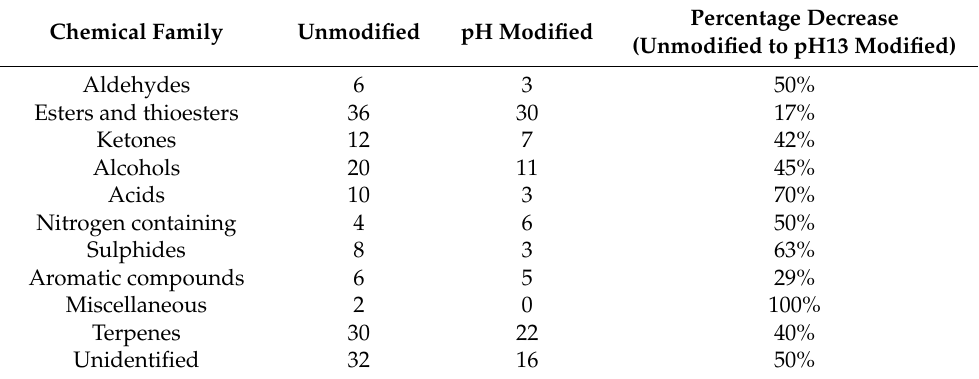
Table 4. Comparison of compounds found across different classes of chemicals in unmodified stool and the stool modified to pH